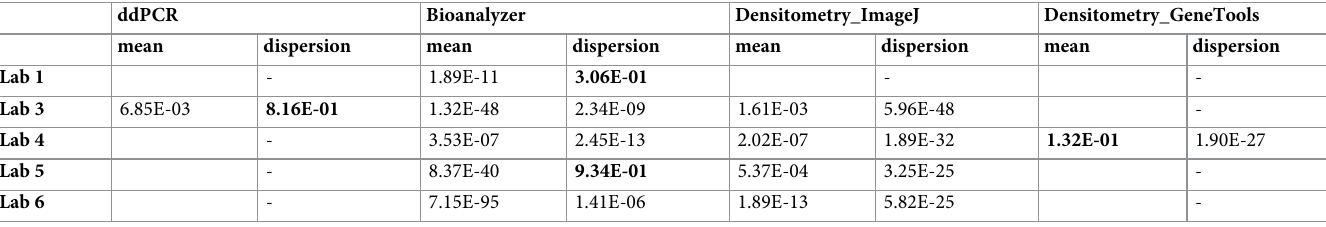
Table 2. P -values obtained for the double generalized linear model.